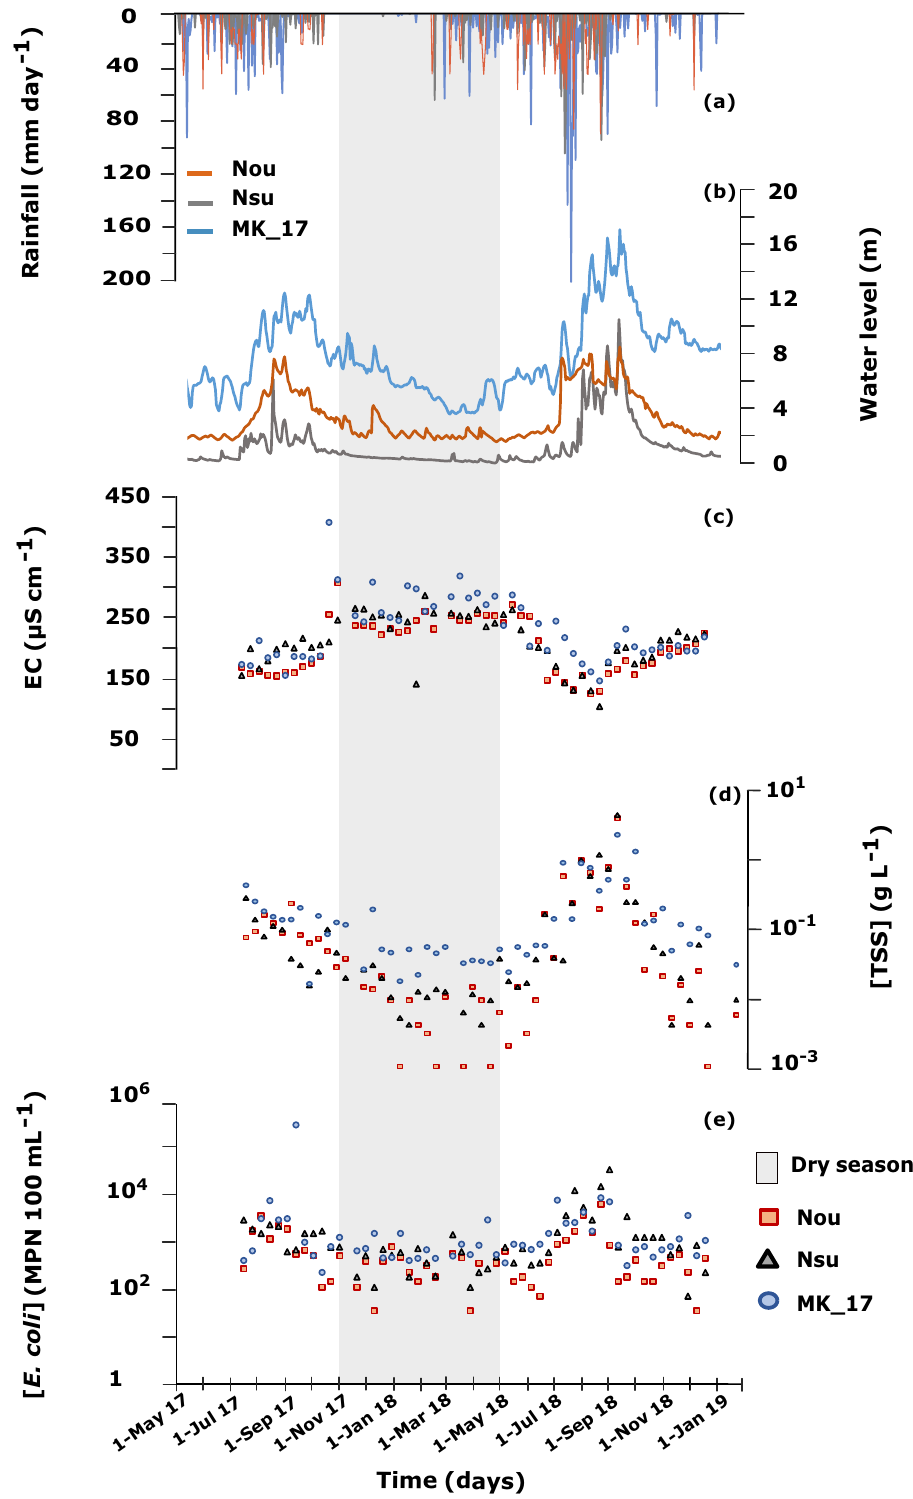
Figure 6. 2017–2018 time series of variables measured at the outlet of three watersheds in northern Lao PDR, Nam Ou (Nou), Nam Suang (Nsu), and Mekong (MK_17): ( a ) daily rainfall (mm day −1 ) taken from meteorological stations of the Department of Natural Resources and Environment of Luang Prabang; ( b ) daily water level (m); ( c ) electrical conductivity (EC, µS cm −1 ); ( d ) total suspended sediment concentration ([TSS], g L −1 ); ( e ) E. coli concentration ([ E. coli ], MPN 100 mL −1 ). The highlighted area in grey represents the dry season (November–May). Figures generated with RStudio (version 1.2.1335; http://www.r-proje ct.org) and edited with Inkscape (version 0.92.4; https ://inksc